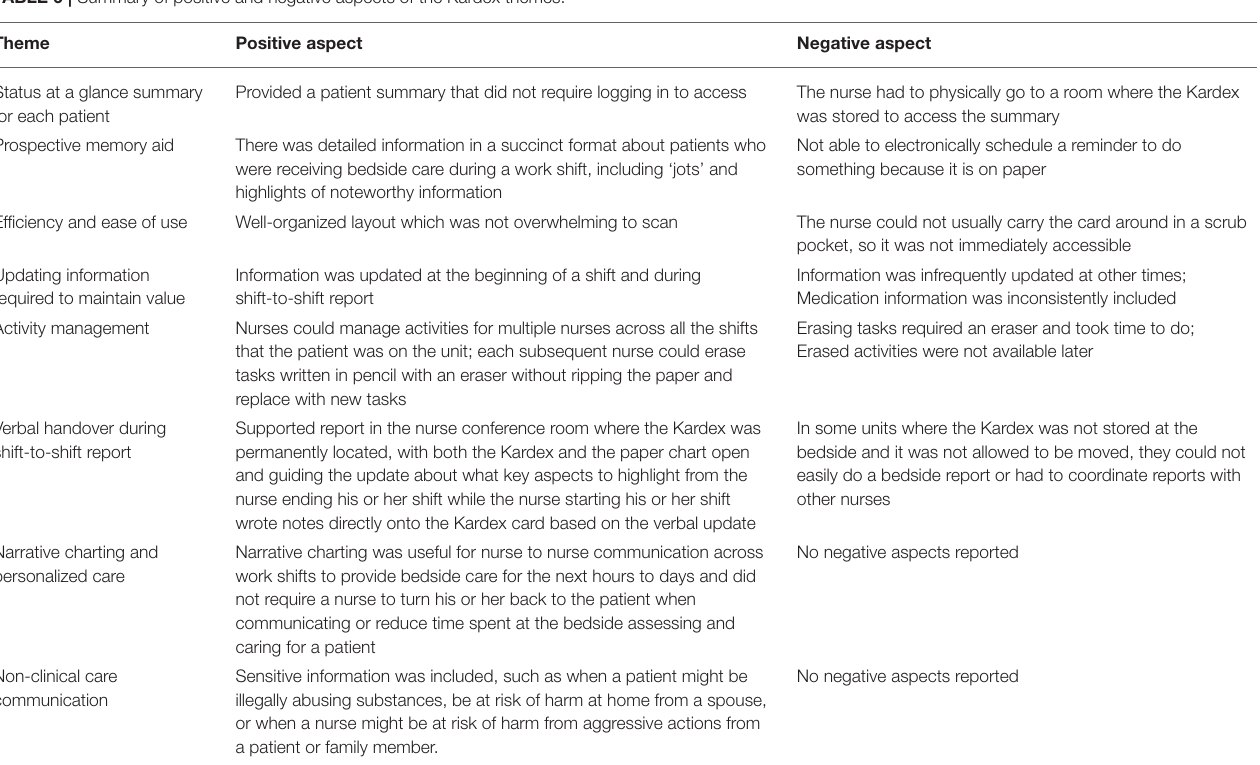
TABLE 6 | Summary of positive and negative aspects of the Kardex